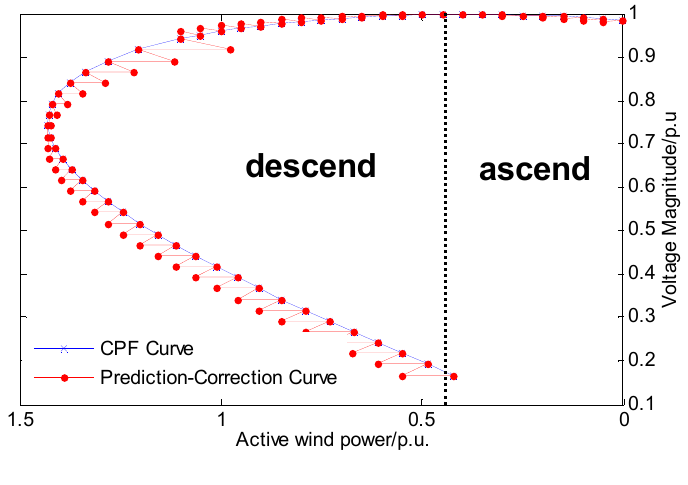
Figure 4. Thevenin equivalent of a wind farm.